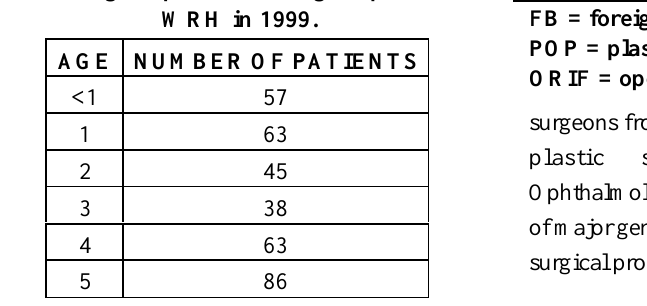
Table I: Age of paediatric surgical patients at WRH in